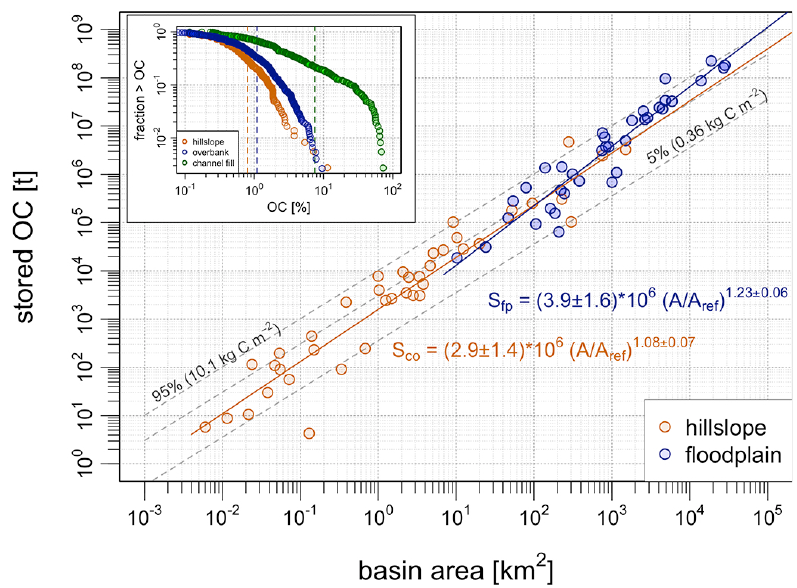
Figure 3. Holocene carbon storage on hillslopes and in floodplains as a function of basin size (Ho ff mann et al., 2013). Lines represent predicted hillslope ( S co ) and floodplain ( S fp ) storage using power law regression with normalized basin area: S = α × ( A × A − 1 coe ffi cient α represent OC-storage [t] at the reference basin area ( A ref = 1000km 2 ) and mainly reflect the greater OC-concentration of floodplain deposits (i.e. overbank and channel fills) compared to hillslope deposits (see inset: cumulative frequency distributions of OC- inventory from hillslope, and floodplain sediments). The scaling exponent of floodplain storage β fp = 1 . 23 ± 0 . 06 indicates a greater increase of floodplain OC with basin than hillslope OC, which is given by β co = 1 . 08 ± 0 . 07 slightly larger than one. These results are in accordance with an increasing accommodation space for floodplain storage with basin size. For details see